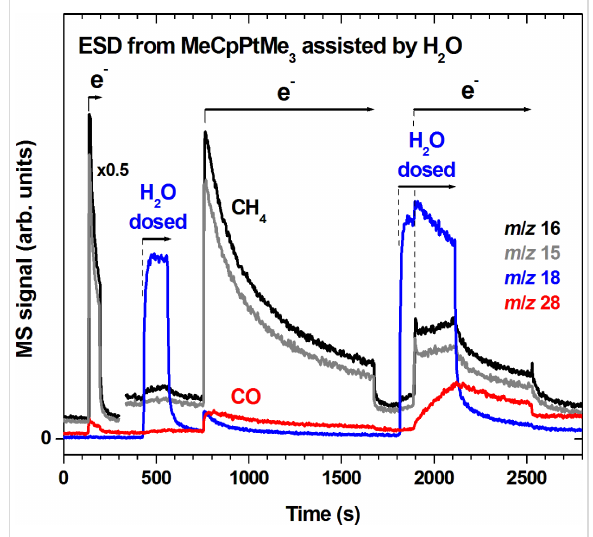
Figure 5: MS signals recorded during repeated electron exposures (e − ) and leaking of H 2 O (H 2 O dosed) onto a 30 layer film of MeCpPtMe 3 deposited and held at 105 K. During the first H 2 O leaking, the amount of vapour was 50% of that used for depositing the MeCpPtMe 3 multilayer film. For the second leaking, the amount of H 2 O vapour was increased by a factor of two. During the three electron irra- diation periods, exposures of 1.04 mC/cm 2 (start at 130 s, I p = 17 µA/cm 2 ), 20 mC/cm 2 (start at 750 s, I p = 22 µA/cm 2 ), and 14 mC/cm 2 (start at 1900 s, I p = 22 µA/cm 2 ) were applied at E 0 = 31 eV. A lower E 0 as compared to Figure 3 was applied here to degrade the layers more slowly and consequently achieve better control over the number of injected electrons. The m / z ratios 18, 16, 15, and 28 were recorded to monitor leaking of H 2 O as well as possible formation of CH 4 (relative intensity of m / z ratios 16 and 15 amounts to 1:0.9 [10]) and CO. Note that m / z 16 also contains a minor fragment signal of H 2